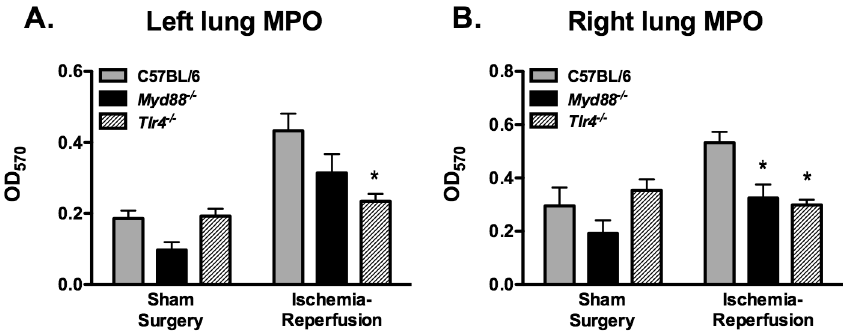
Figure 4. Myeloperoxidase activity in left lung (A) and right lung (B) homogenates of mice subjected to 1 hr of left lung warm ischemia and 4 hr of reperfusion (n = 12/grp for C57BL/6 and Tlr4 -/- ; n=11 for Myd88 -/- ). Sham surgery mice (n = 4/grp) were not subjected to left lung ischemia. *p ≤ 0.05 when compared with C57BL/6 mice.